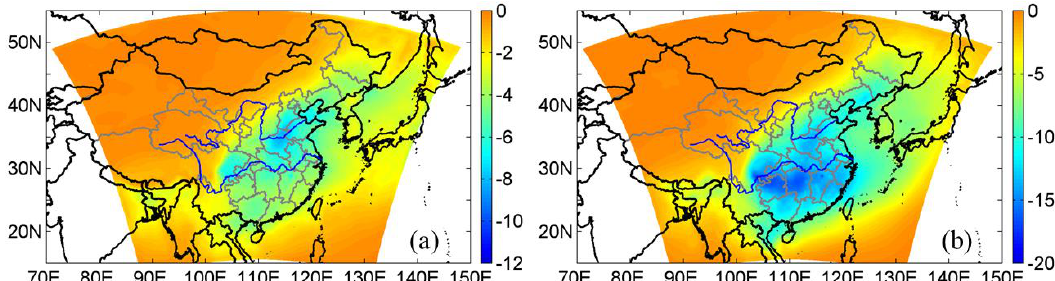
Figure 5. Annual mean direct radiative forcing (DRF) due to nitrate at the top of the atmosphere (TOA) under ( a ) all-sky and ( b ) clear-sky conditions in 2010.